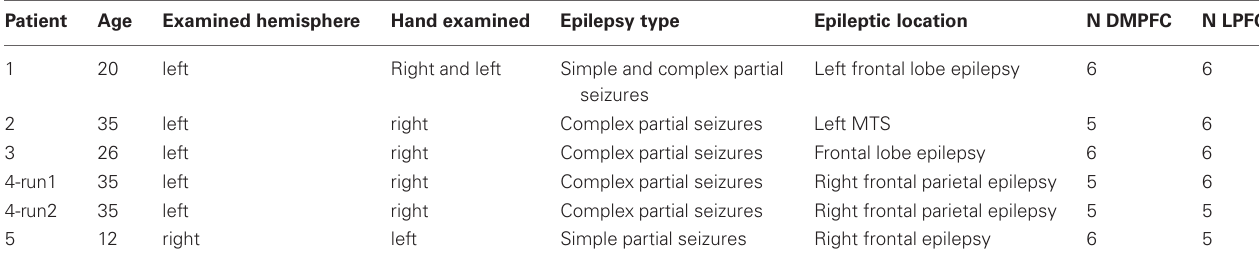
Table 2 | Details of epilepsy type and electrode